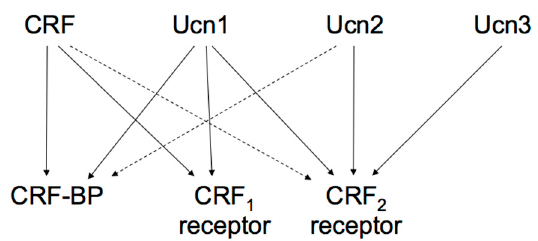
Figure 2. Proposed signaling mechanisms of corticotropin-releasing factor (CRF), urocortins (Ucns) and CRF receptors. CRF-BP, CRF-binding protein. Solid lines represent a high affinity binding, and dashed lines a low affinity binding.